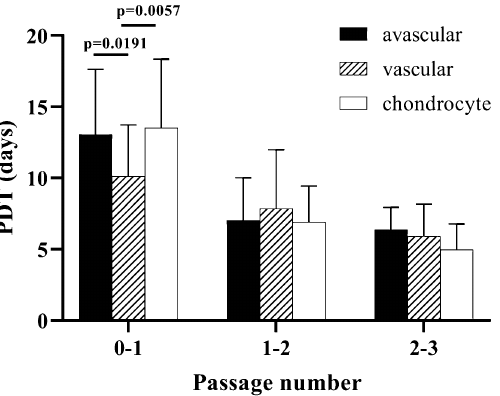
Figure 4. Graph to show the population doubling time (PDT) of avascular, vascular meniscal cells and chondrocytes during cell culture relative to passage number (passage 0–3). Data shown are the means ± the standard deviation .